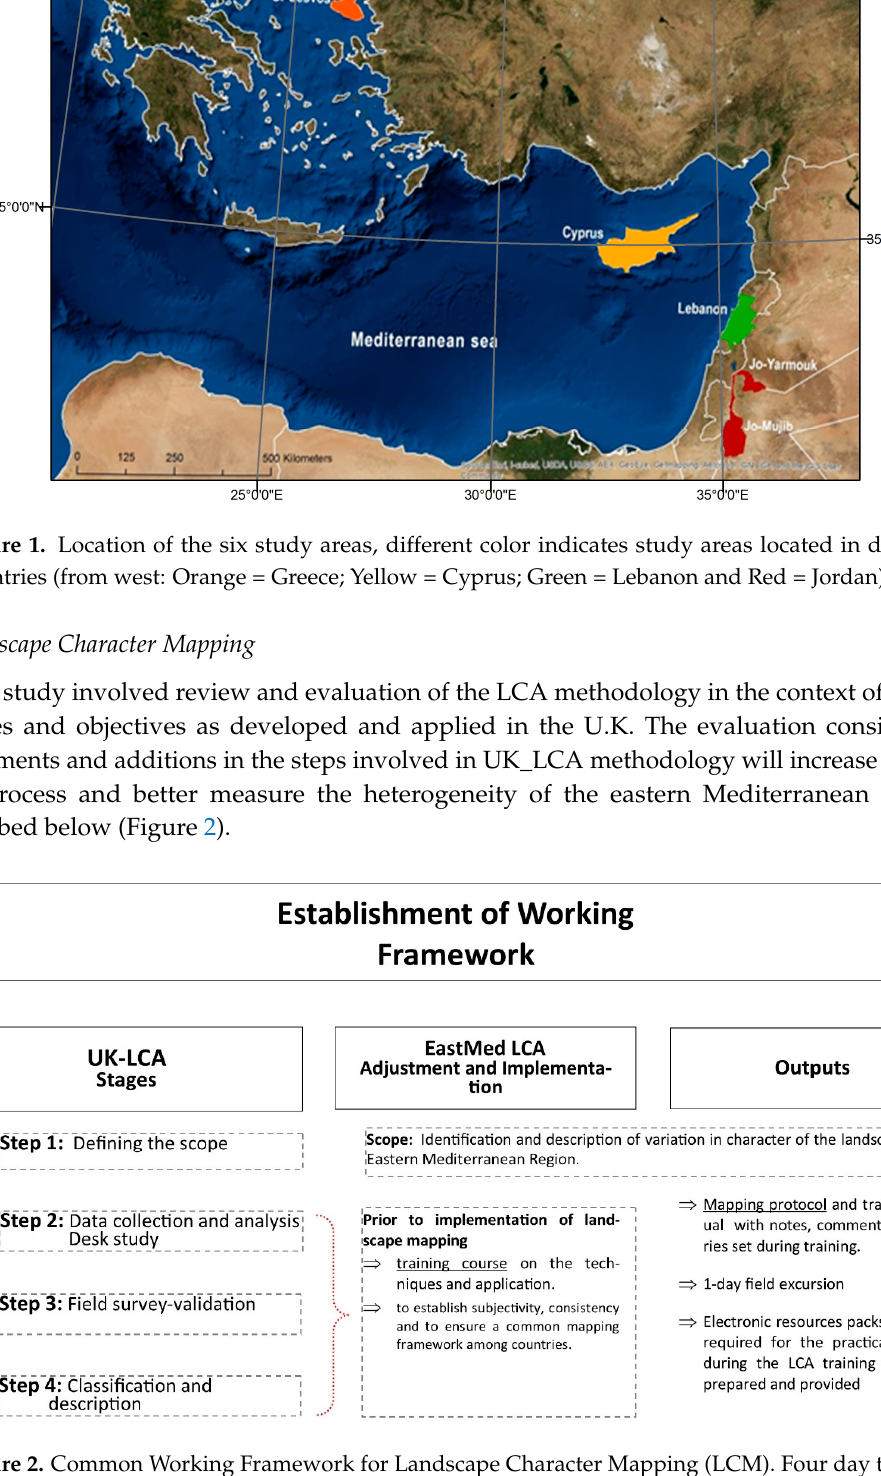
Figure 2. Common Working Framework for Landscape Character Mapping (LCM). Four day training was provided to all teams covering the basics of LCA process including GIS mapping, field validation and evaluation for decision-making and planning.